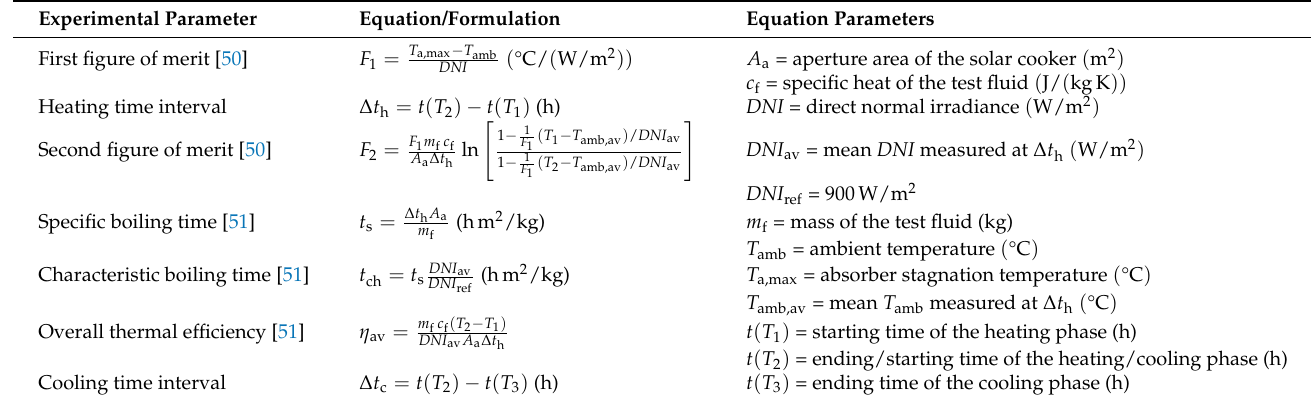
Table 5. Experimental parameters for the assessment of the solar cooker